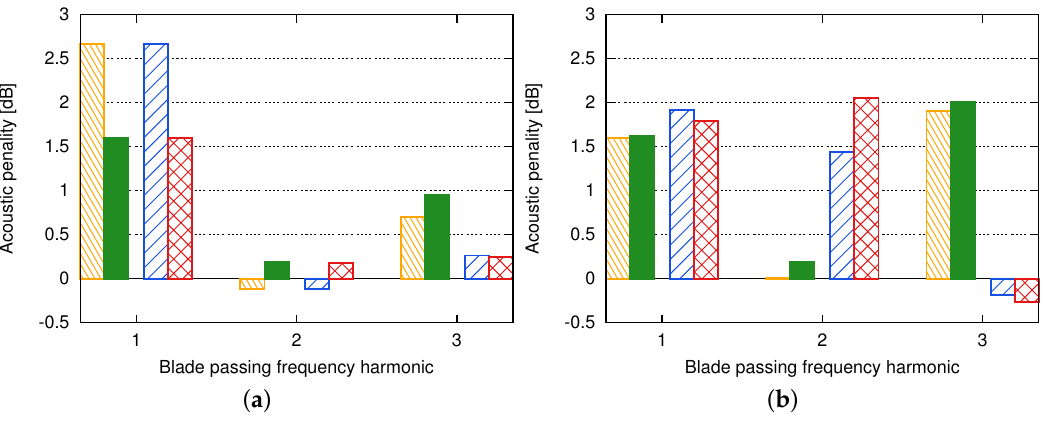
Figure 22. Sensitivity of the total acoustic penalty caused by the air-inlet distortion to the set of parameters. First set in densely-hatched orange bars, second set in filled green bars, third set in sparsely hatched blue bars and fourth set in crosshatched red bars. ( a ) Upstream; ( b )